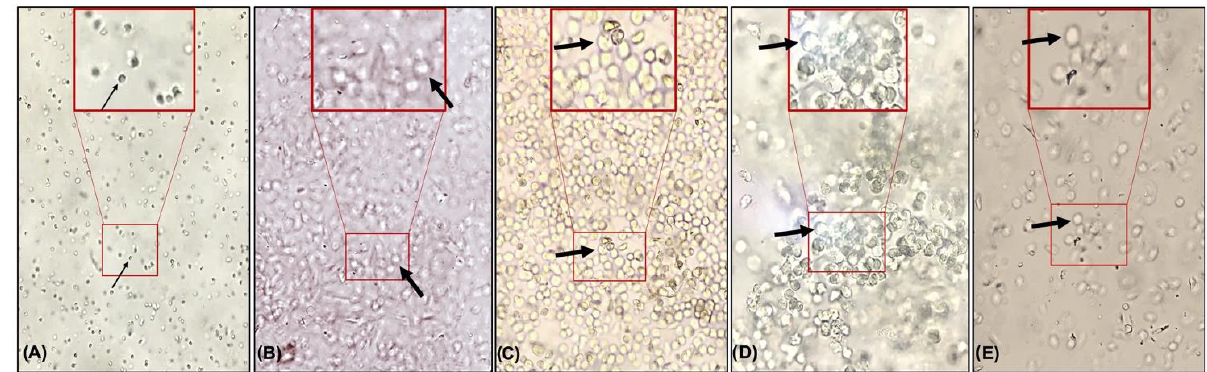
Figure 2. Photomicroscopy (10×) of cells present in the vaginal lavage of animals treated with saline ( A ), estrogen ( B ), flaxseed extract ( C ), mulberry ( D ), and flaxseed + mulberry ( E ). The thin arrow indicates leukocyte cells, and the thick arrow indicates epithelial cells.